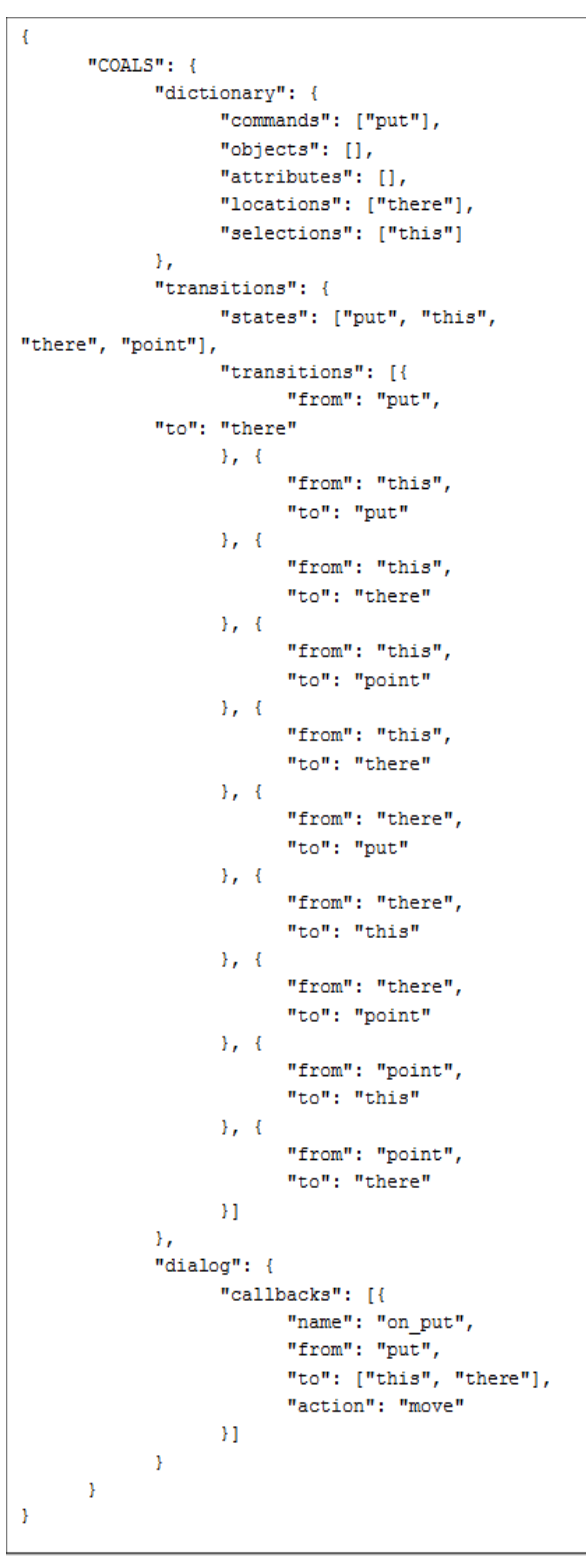
Figure 3: An example of a COALS